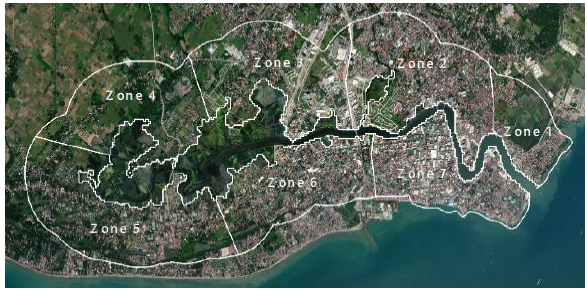
Figure 2. Delineated zones for the study